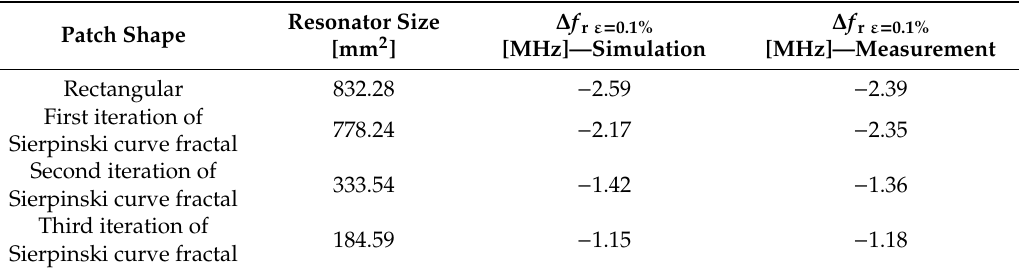
Table 3. Comparison of the examined